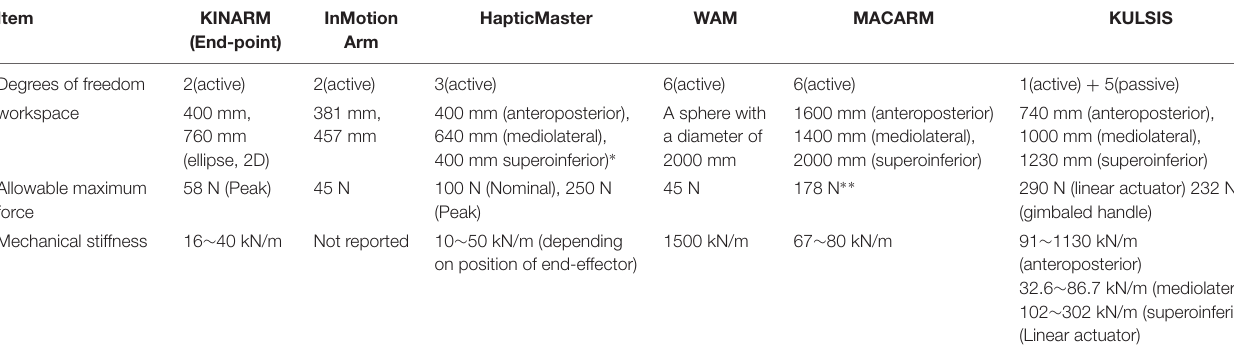
TABLE 3 | Specification of various experimental setups for upper limb intermuscular coordination evaluation. Item KINARM InMotion (End-point) Arm Degrees of